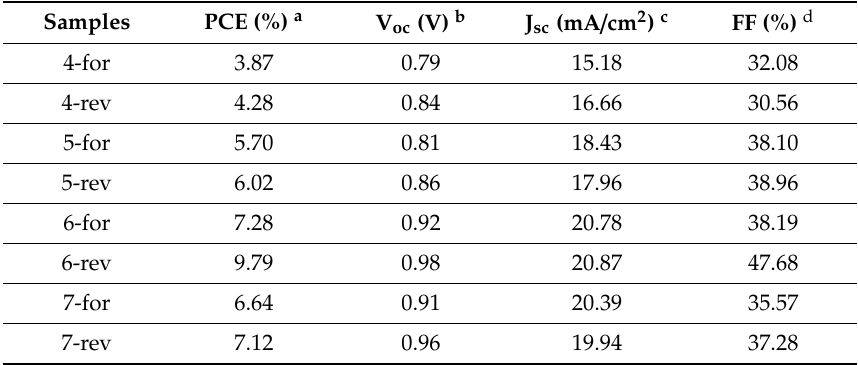
Table 1. Performance parameters of perovskite solar cells prepared with di ff erent concentrations of formamidine methylamine halide precursor solution.